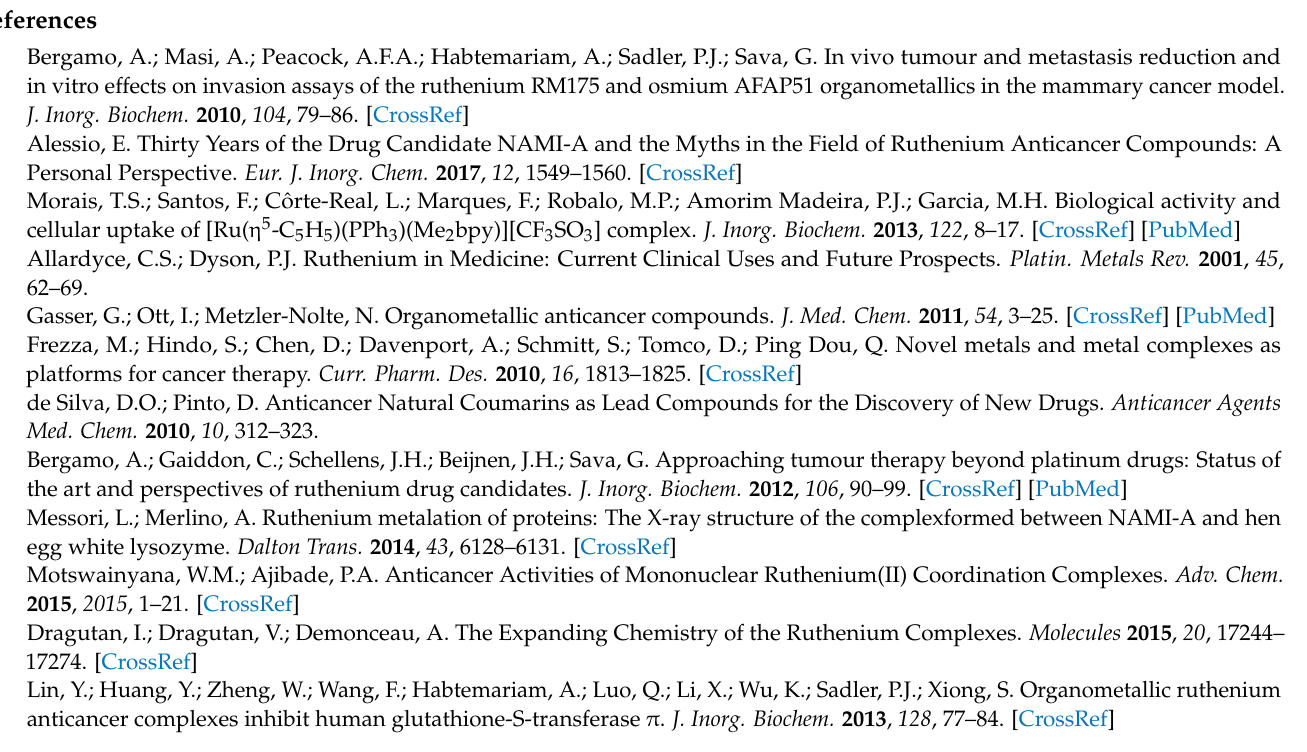
[RuH(CO)(PPh 3 ) 2 ] 4 , Figure S11a: 31 P{ 1 H} NMR (161,9 MHz) κ 1 (O)-[RuH(CO)(THAc)(PPh3)3 3a,b + κ 2 (O,O)-[RuH(CO)(THAc)(PPh 3 ) 2 ] 4 in CDCl 3 , Figure S11b: 1 H-NMR spectrum of 3 + 4 (ratio 3:2) showing iminol/keto ratio = 0.31 in CDCl 3 , Figure S11c: 1 H-NMR spectrum of 3 + 4 (ratio 3:7) in CDCl 3 showing iminol/keto ratio = 0.25, Figure S11d: Complexes formed as impurities during the preparative reduction of starting material 1 , Figure S12: Electrospray ionization mass spectrometry (ESI MS) (MeOH) of κ 2 (O,O)THAc-[Ru(CO)H(PPh 3 ) 2 ] 4 , Figure S13: 1 H-NMR hy- dride region spectrum of 1 + κ 1 (O)Ac-[RuH(CO)(PPh 3 ) 2 ] 5 + κ 2 (O,O)Ac-[RuH(CO)(PPh 3 ) 2 ] 6 in CDCl 3 , Figure S14a: FT-IR of compound 5 , Figure S14b: 31 P{ 1 H}-NMR spectrum of κ 2 (O,O)Ac- [RuH(CO)(PPh 3 ) 2 ] 6 species, Figure S15: 13 C{ 1 H}-NMR spectrum of 6 species, Figure S16: FT-IR (KBr) κ 1 (O)Ac-, κ 2 (O,O)Ac- [Ru(CO)(PPh 3 ) 2 ], 7 , Figure S17: Carbonyl region in 13 C{ 1 H}-NMR spec- trum of ( trans + cis )(P,P)- κ 1 (O)Ac,- κ 2 (O,O)Ac-[Ru(CO)(PPh 3 ) 2 ] 7 in CDCl 3 , Figure S18a: portion of 1 HNMR spectrum in hydride region of intermediate κ 1 (O)-, κ 2 (O)-[THCH 2 C(O)O ··· H ··· OC(O) CH 2 TH][RuH(CO)(PPh 3 ) 2 ][TH=thymine ring] A , Figure S18b: portion of 1 HNMR spectrum in hy- dride region of intermediate κ 1 (O), κ 2 (O)-[MeC(O)O ··· H ··· OC(O)Me][RuH(CO)(PPh 3 ) 2 ] B , Figure S18c: 1 H-NMR portion of the spectrum of A in CDCl 3 displaying the CH 2 moiety of the Et 2 O solvent, remarkably shifted upon Ru-coordination, Figure S18d: 1 H-NMR portion of the spectrum of A in CDCl 3 displaying the CH 3 moiety of the Et 2 O solvent, shifted upon